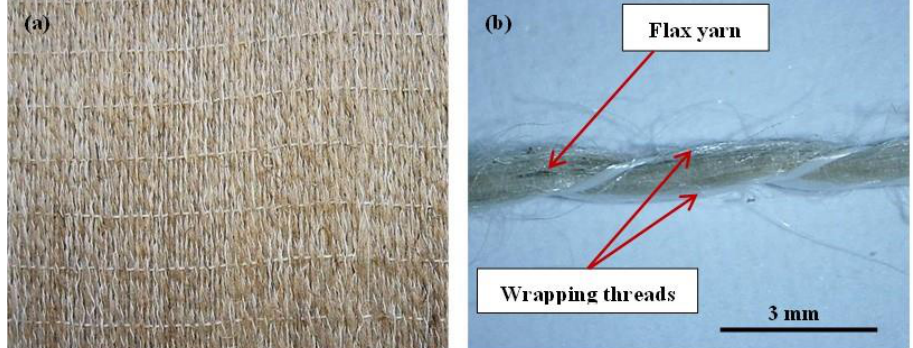
Figure 2. ( a ) Biotex unidirectional flax fabric and ( b ) a yarn from the fabric.